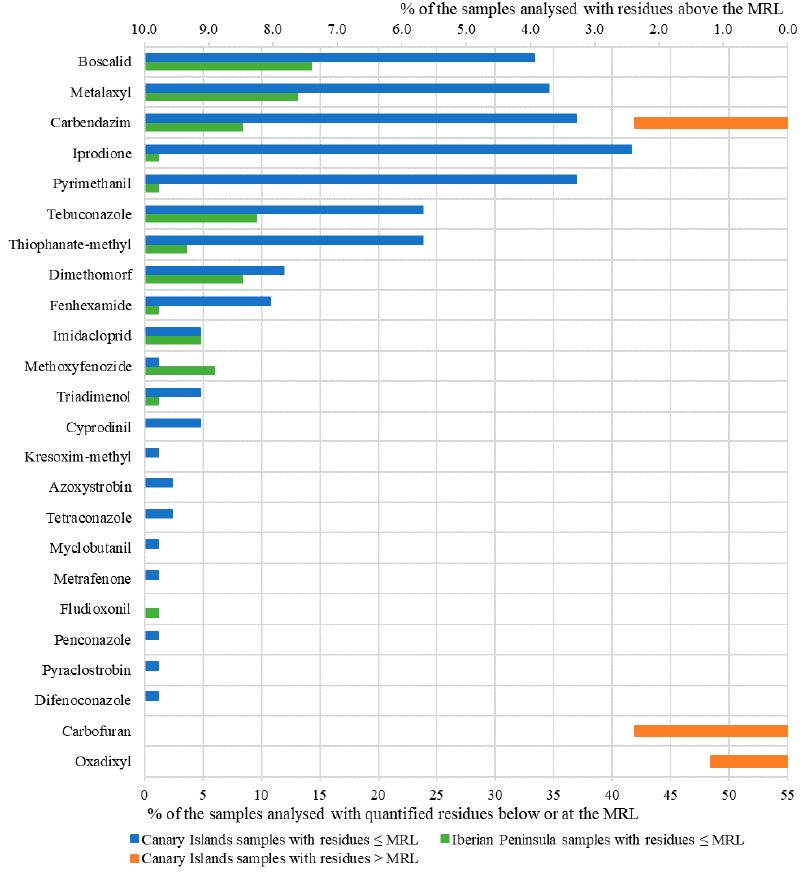
Figure 2. Percentage of the Canary Islands and the Iberian Peninsula red wine samples, over total samples, with quantified residues below or equal to their maximum residue limits (MRLs) and with residues above the MRL set for wine grapes (default processing factor (PF) of 1 applied according to Regulation (EU) No 2015/595).